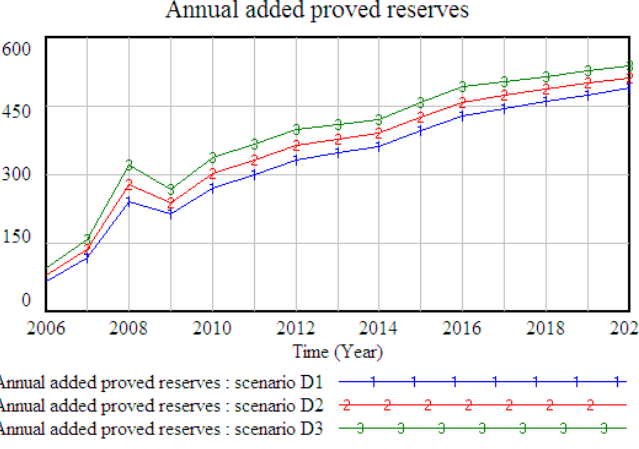
Figure 10. Annual production capability (billion cubic meters).